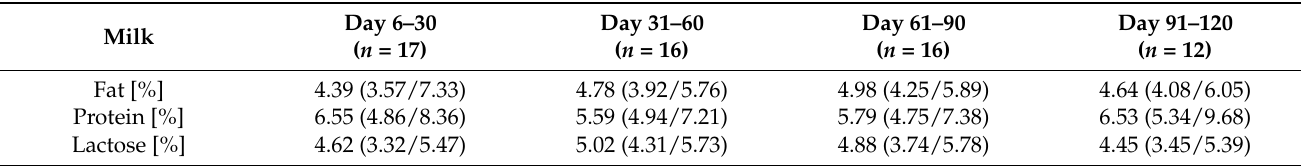
Figure 2. ( a ) Boxplot of fat concentration in alpaca milk during four months postpartum, there were no significant differences between the months. ( b ) Boxplot of protein concentration in alpaca milk during four months postpartum, there were no significant differences between the months. ( c ) Boxplot of lactose concentration in alpaca milk during four months postpartum, there were no significant differences between the months. Table 3. Percentages of fat, protein and lactose in alpaca milk during four months postpartum, data are provided as median (1st quartile/3rd quartile); there were no significant differences between the months.